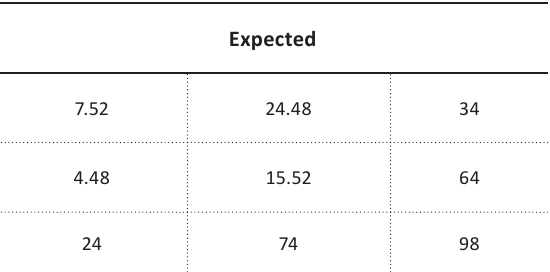
Table 9. Expected frequency for H2